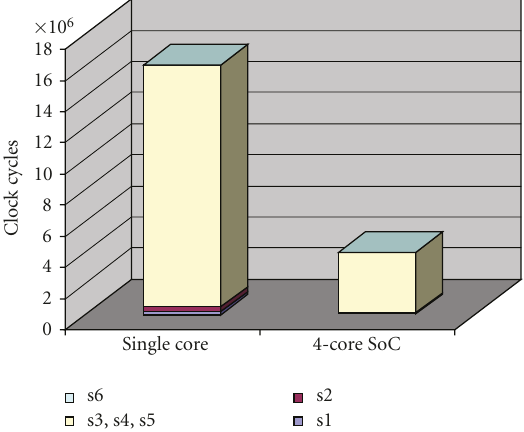
Figure 7: Performance of data processing on a single and a four- core